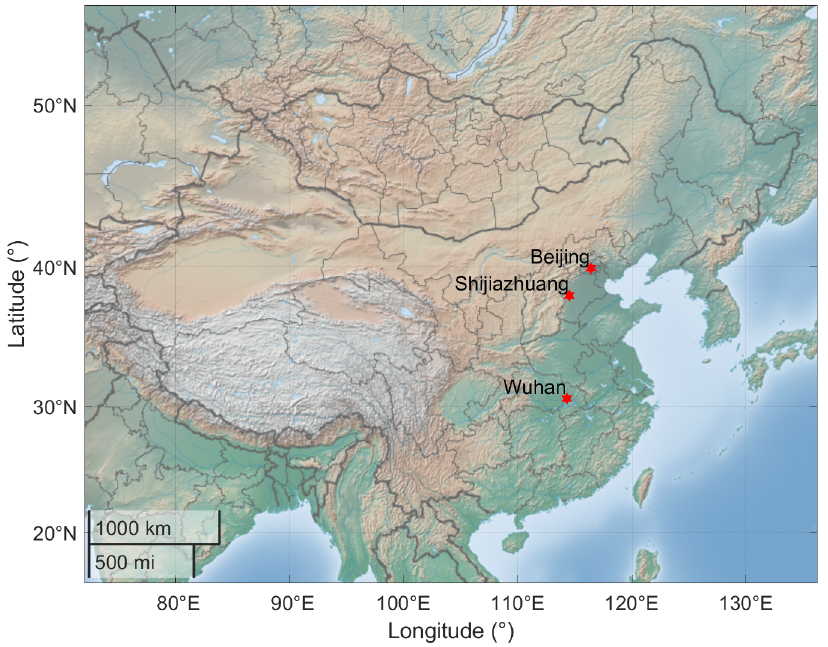
Figure 2. The study